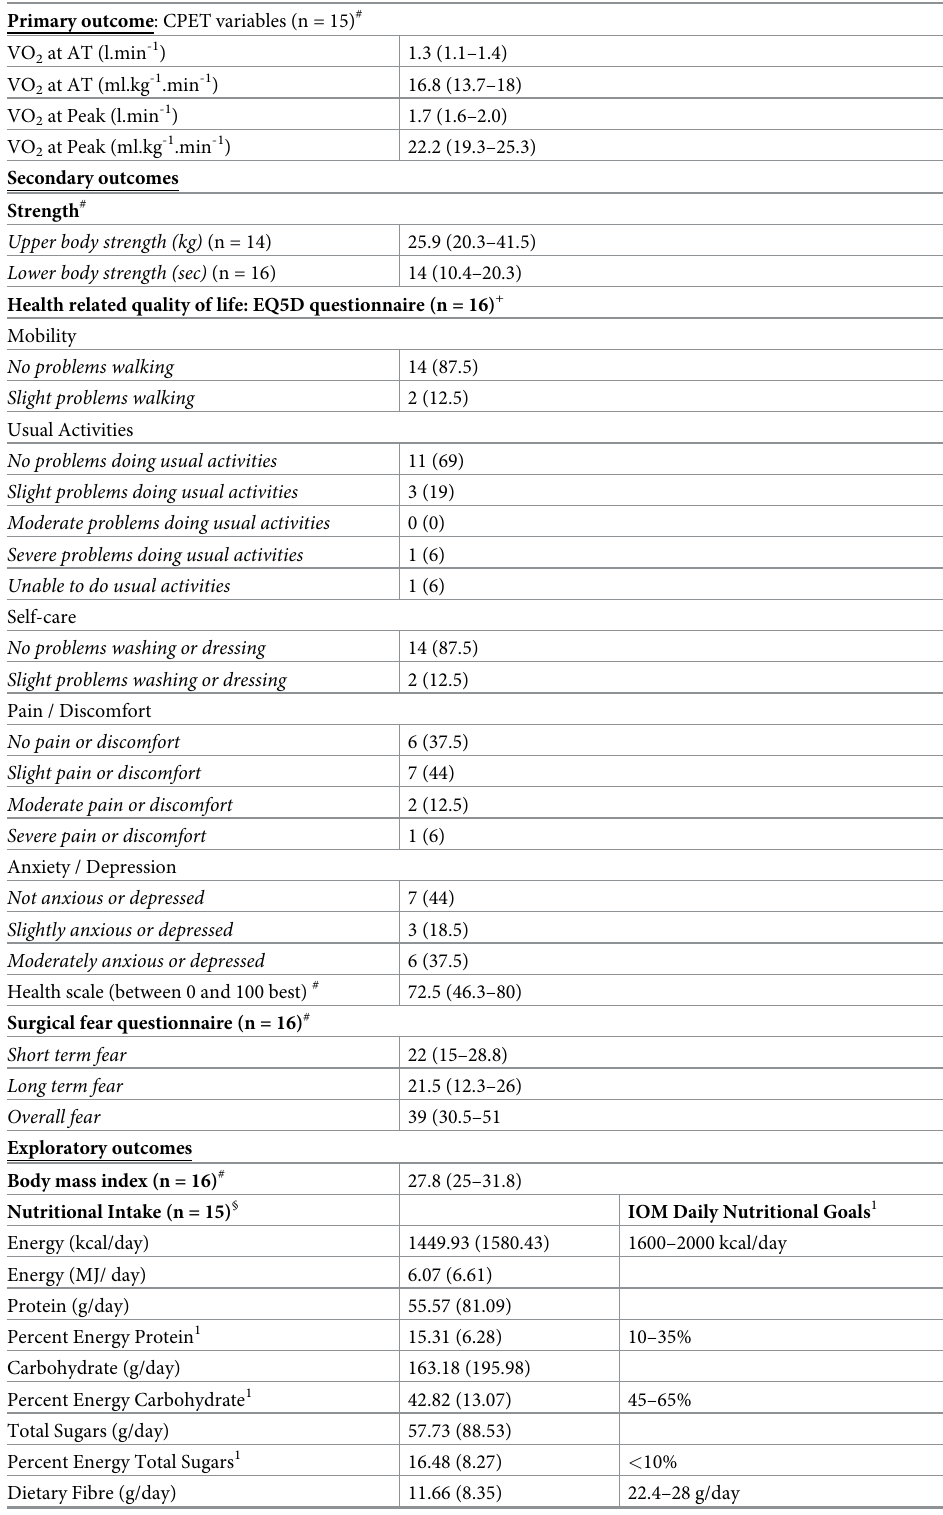
Table 2. Pre-operative outcomes measures prior to